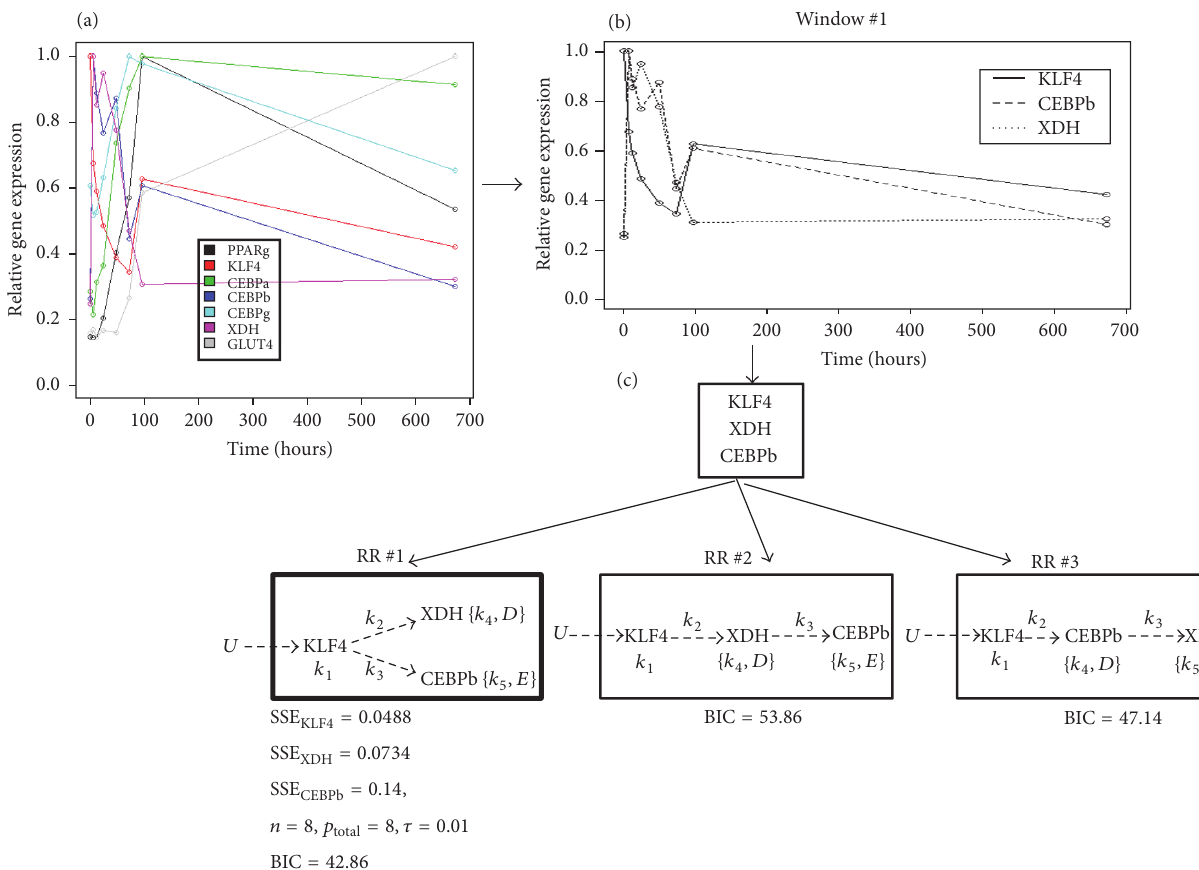
Figure 4: Window #1 network inference. (a) Time-series gene expression data of 7 genes within the adipogenesis network collected at 0, 6, 12, 24, 48,72, 96, and672 hoursduringadipocytedifferentiation [9].GEOaccession numberofgeneexpressiondata isGSE6795. Geneexpression values were normalized to a maximum value of 1. Expanded view of gene expression data between 0 and 100 hours is shown in Supplementary Figure S1. (b) Time-series expression profiles of the three genes selected from the pool of 7 genes for window #1. (c) The parameters of different RegulatoryRelationships(RRs)werefittedtothetime-seriesdataofgenesshownin(b).SinceKLF4wasdeterminedtobethegeneatthetopof the hierarchy, the two remaining genes were fitted in parallel or serial regulatory relationships. Parameters describing the different regulatory relationshipsareasdescribedinFigure 3.BICscoresofregulatoryrelationshipswereestimatedas ( SSE KLF 4 + SSE XDH + SSE CEBPb )/𝜏+𝑝 total ⋅ ln (𝑛) . Parallel regulatory relationship (RR #1) was chosen as optimal to describe gene relationships in window #1 because of its smallest BIC score. The parameters estimated for the selected regulatory relationship are listed in Table 1.